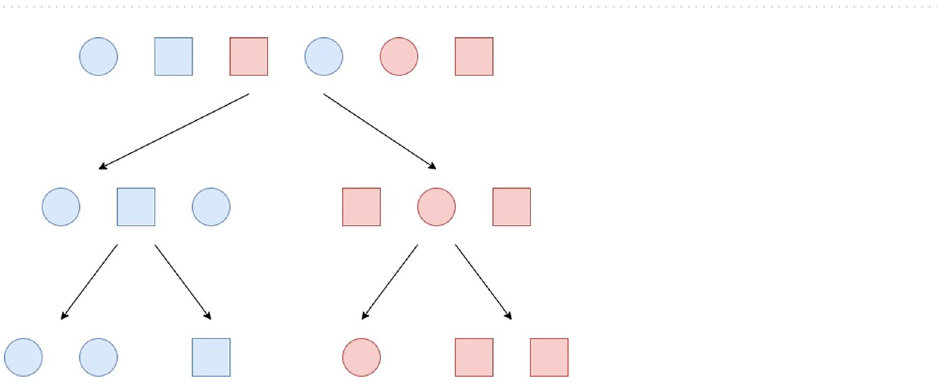
Figure 20. Feature visualization for selected SARS-CoV-2 and Coronaviridae sample.